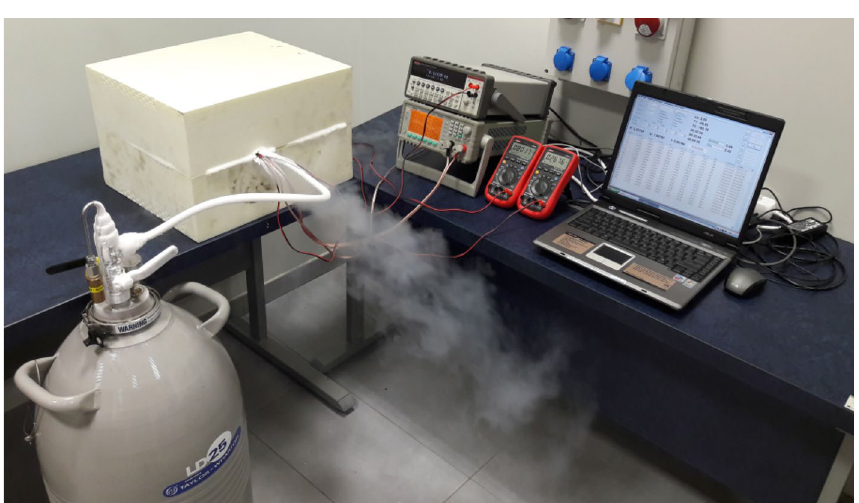
Figure 9. Test bench for measuring the power losses in the gearset operating under low